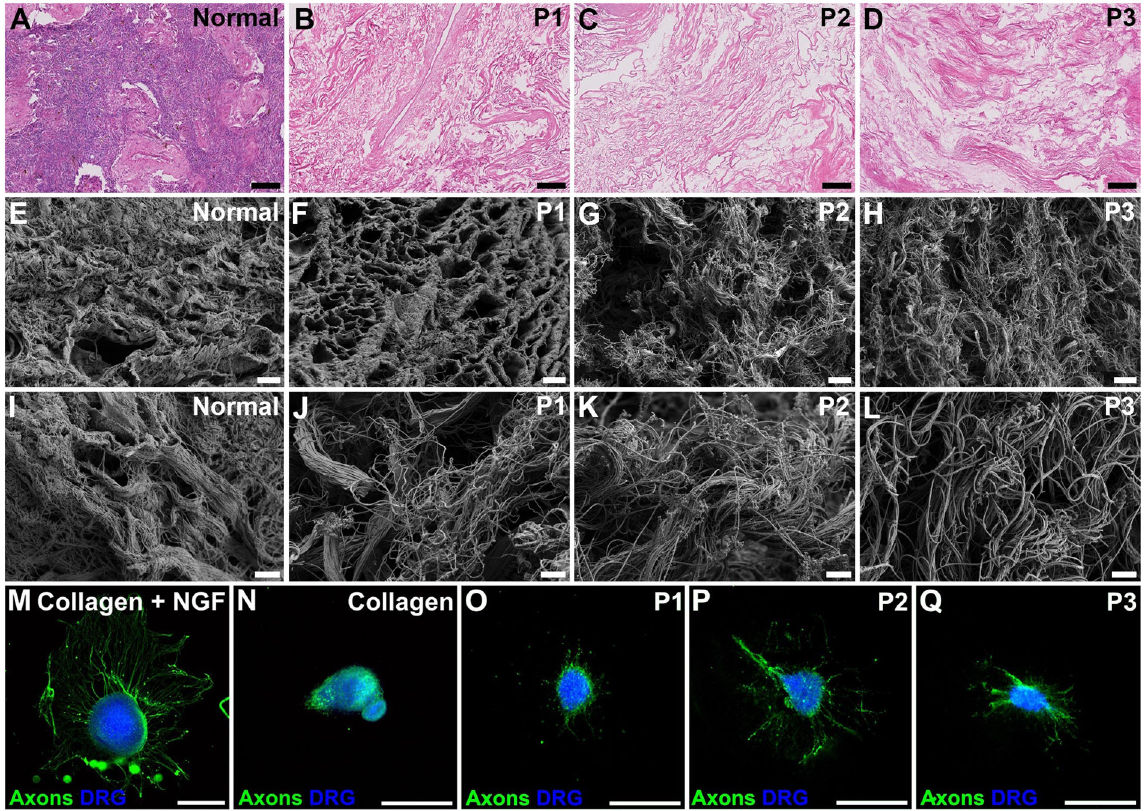
Fig. 1 Morphological and bioactivity assessment of developed sheep uterus scaffolds. Hematoxylin and eosin-stained sections from normal and decellularized uterus showed that the extracellular matrix was well-preserved and that all hematoxylin positive nuclei had been removed by the different decellularization protocols ( A – D ; scale bar = 100 μ m). Scanning electron microscopy pictures obtained at ×3000 magni fi cation ( E – H ; scale bar = 8 μ m) showed that protocol (P) 1 generated scaffolds resulted in an organized porous structure ( F ) while